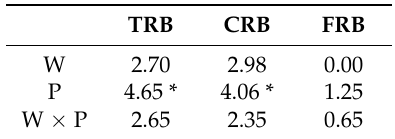
Table 3. F-ratios of two-way ANOVA on the effects of warming (W) and precipitation manipulation (P) on total root biomass (TRB), coarse root biomass (CRB), and fine root biomass (FRB) of Pinus densiflora seedlings.